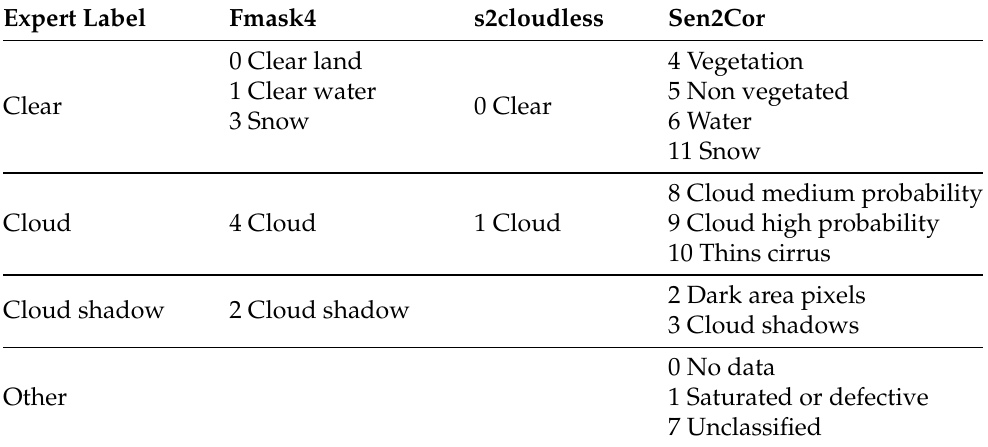
Table 1. Updated version of Table 3 [1]. Label recoding of the detection algorithms.